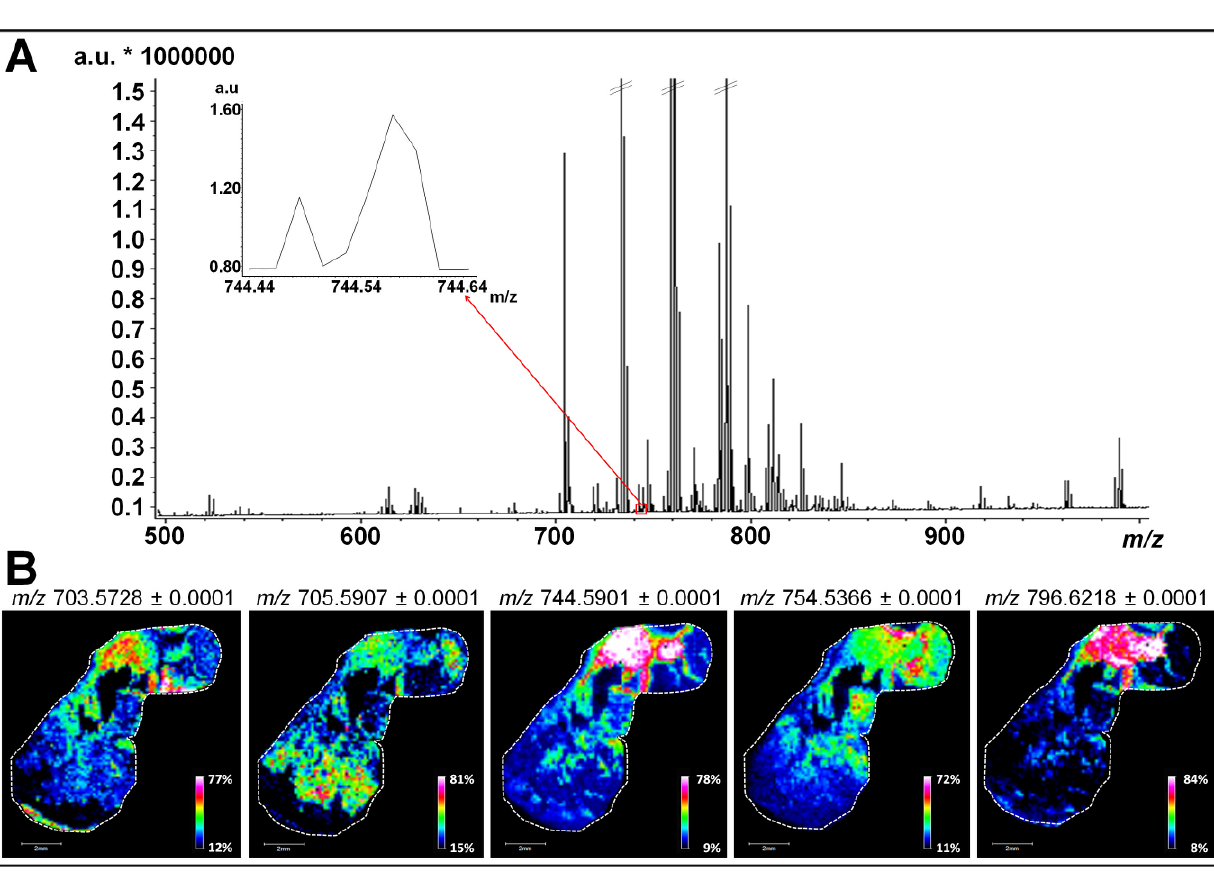
Figure 2. Large scale lipid analysis by MALDI MSI for low-abundant lipids of biological relevance targeting. ( A ) Broadband average mass spectrum of a simultaneous MALDI MSI analysis on sections of tumors derived from MCF-7, MDA-MB-231, and MDA-MB-435 cells. Inset indicates molecular species in a mass range comprised between m/z 744.44 and 744.64 considered for lipid mapping; and ( B ) MALDI MSI ion image representing the repartition of five low-abundant PLs ( m/z 703.5728, m/z 705.5907, m/z 744.5901, m/z 754.5366 and m/z 796.6218) in a MDA-MB-435 tissue section (scale bars, 2